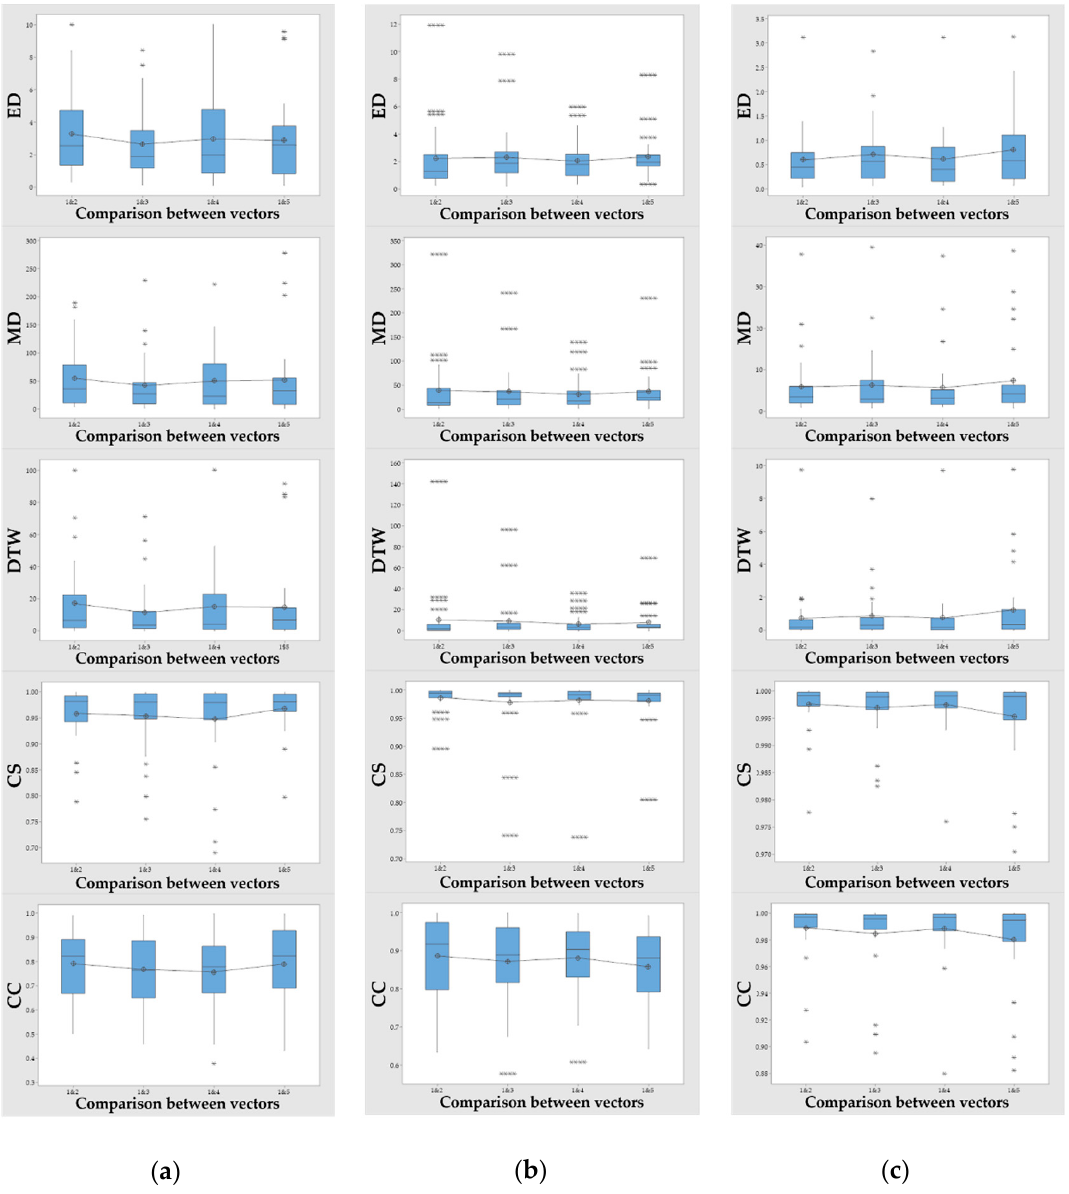
Figure 7. Analysis of the similarity between the two time series vectors, ED, MD, DTW, CS and CC in turn: ( a ) x , ( b ) y , ( c ) z axes.